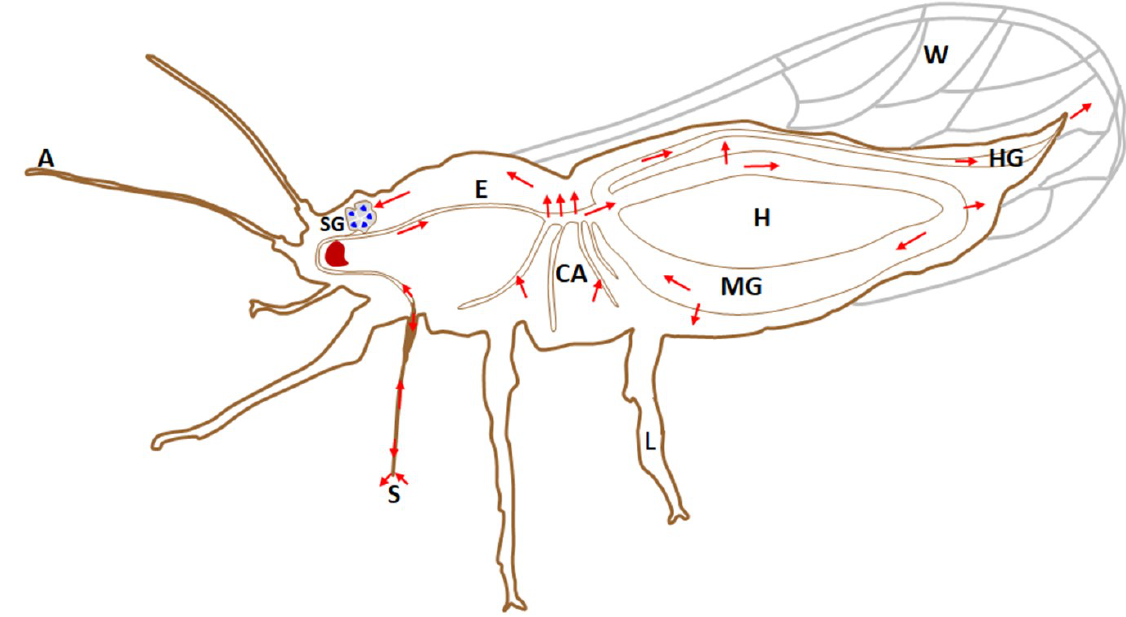
Figure 2. A graphical illustration of the internal anatomy and organs of an adult psyllid, showing the circulative pathway that bacteria of the genus Liberibacter pass through during the transmission process. Red arrows show the pathway, which starts with acquisition from an infected plant through the stylet (S), moves along the esophagus (E), reaches the midgut (MG), where the bacterium is absorbed into the hemolymph (H), circulates and reaches the salivary glands (SG), from which it is secreted into the newly infected plant through the salivary canal in the stylet. A, antennae; CA, caeca; W, wings; HG, hindgut; L, leg.